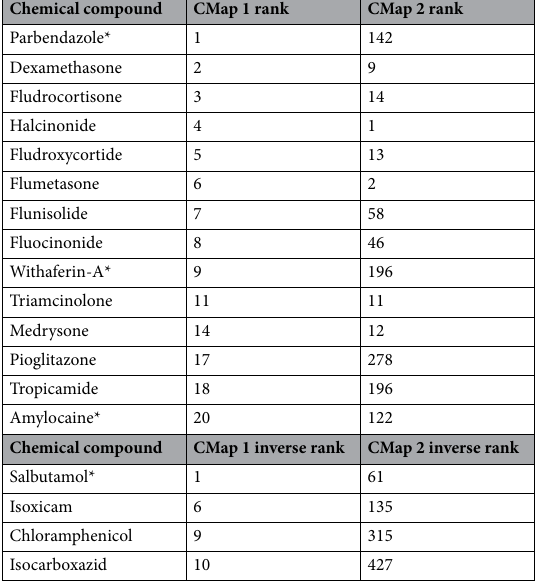
Table 1. Compound rankings from GSEA-analysis using previously reported signatures from Brum et al. (2015 and 2018). Inverse-ranks are reported for “reversing” the query signature. Compounds marked with asterisks (*) were experimentally validated. The CMap 2 ranks are relative to CMap 1 compounds contained in CMap 2.